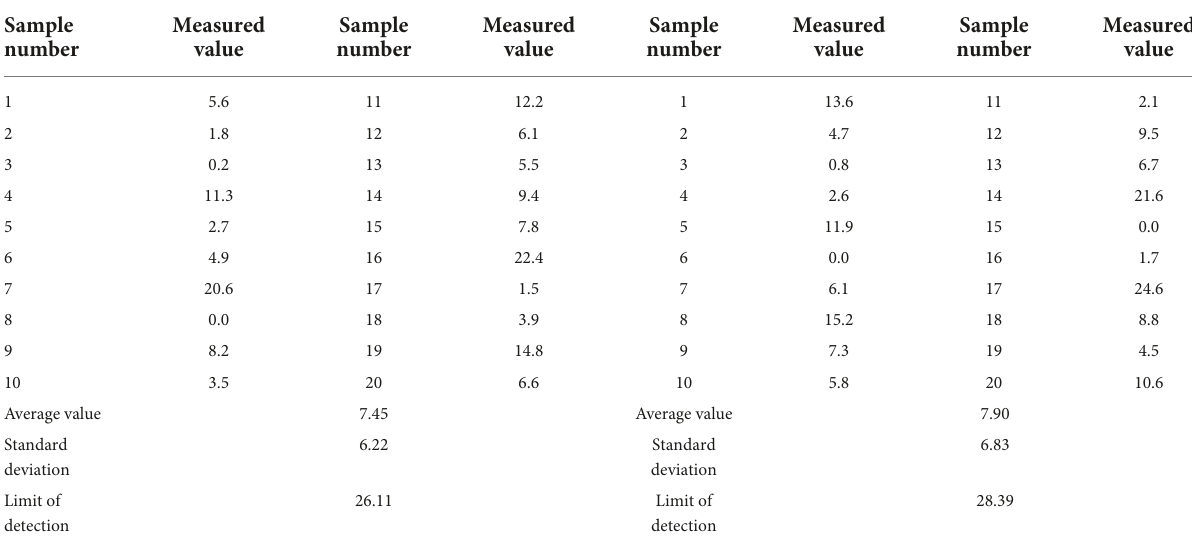
TABLE 3 Test strip detection limit determination results ( µ g/kg).